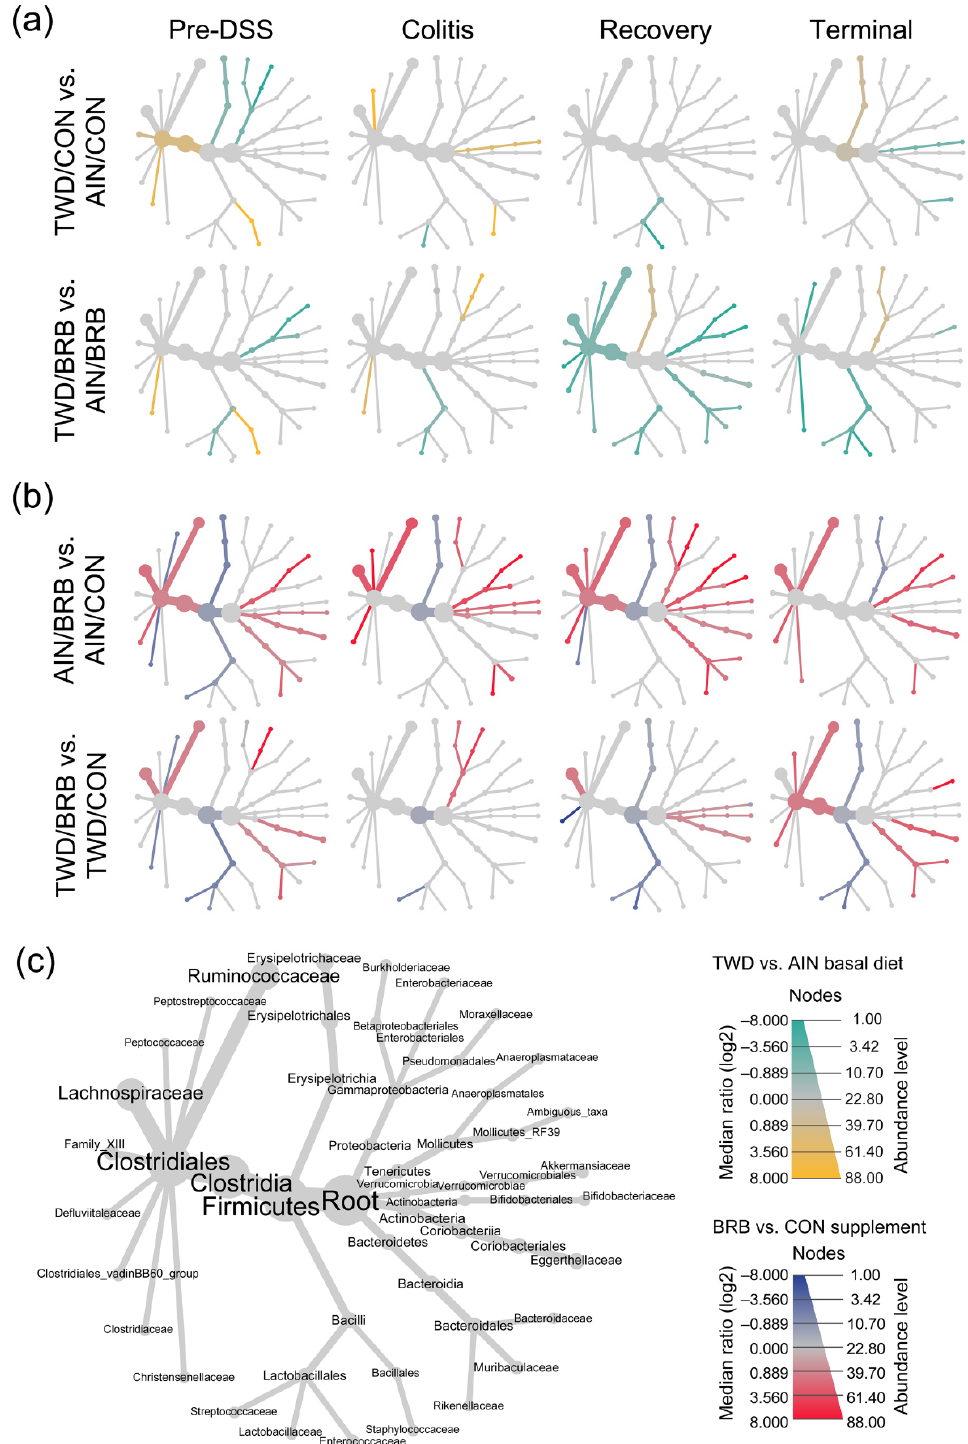
Figure 8. Fecal microbiome community structures depicted as heat trees showing the relative abundance ratios for selected comparisons of basal diet and BRB supplement at each experimental time point (experiment B). ( a ) Comparisons of TWD versus AIN basal diet with or without BRB supplementation (green-to-yellow color bar, with yellow indicating greater abundance in TWD-fed mice; top legend). ( b ) Comparisons of BRB versus CON supplement for AIN or TWD basal diets (blue-to-red color bar, with red indicating greater abundance in BRB-supplemented mice; bottom legend). ( c ) Phylogenetic structure of fecal microbiome bacteria community.